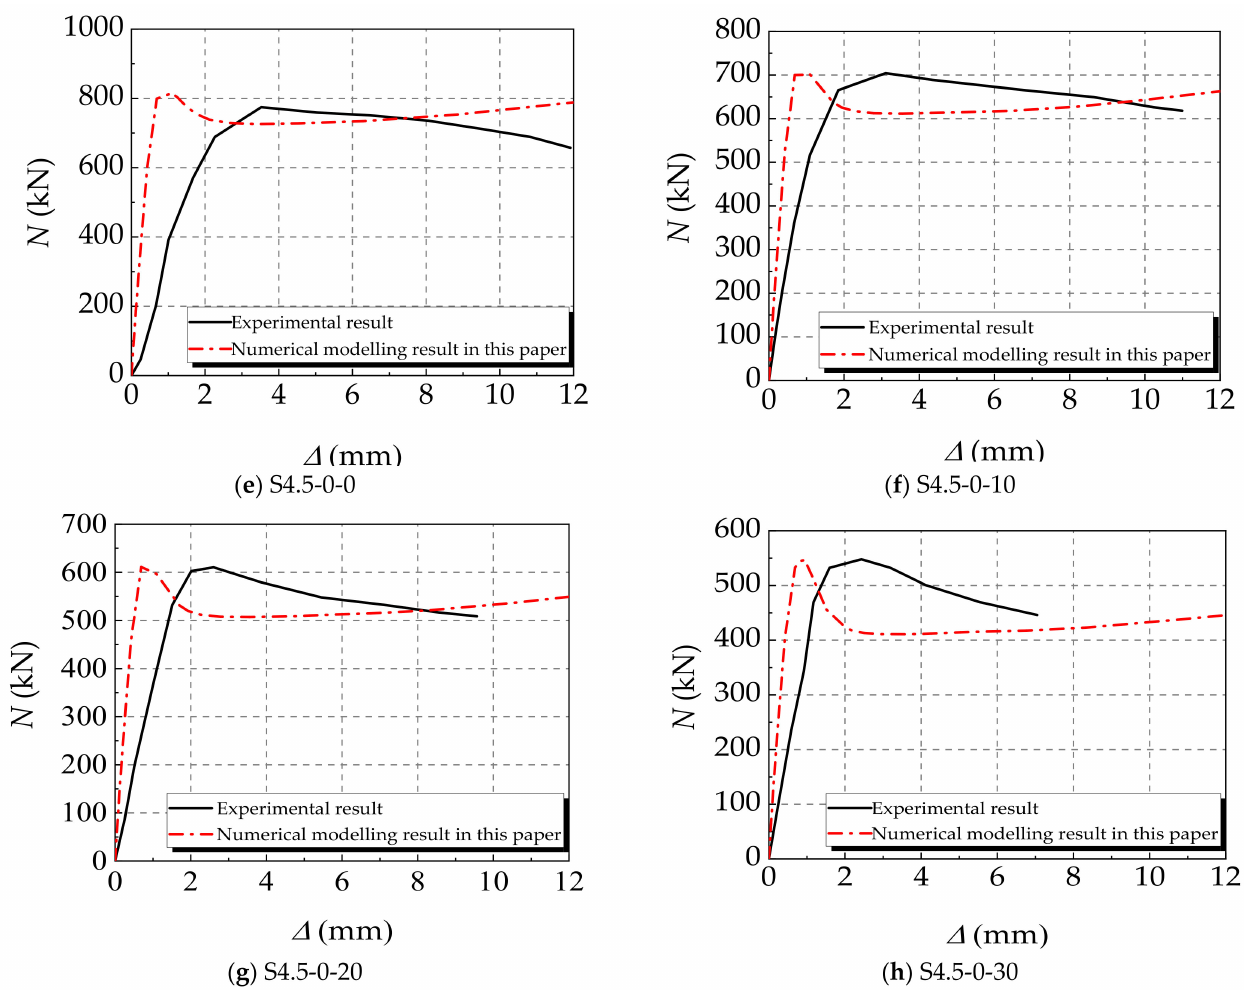
Figure 3. Results verification of Ref. [35]. ( a ) S3-0-0; ( b ) S3-0-10; ( c ) S3-0-20; ( d ) S3-0-30; ( e ) S4.5-0-0; ( f ) S4.5-0-10; ( g ) S4.5-0-20; ( h )